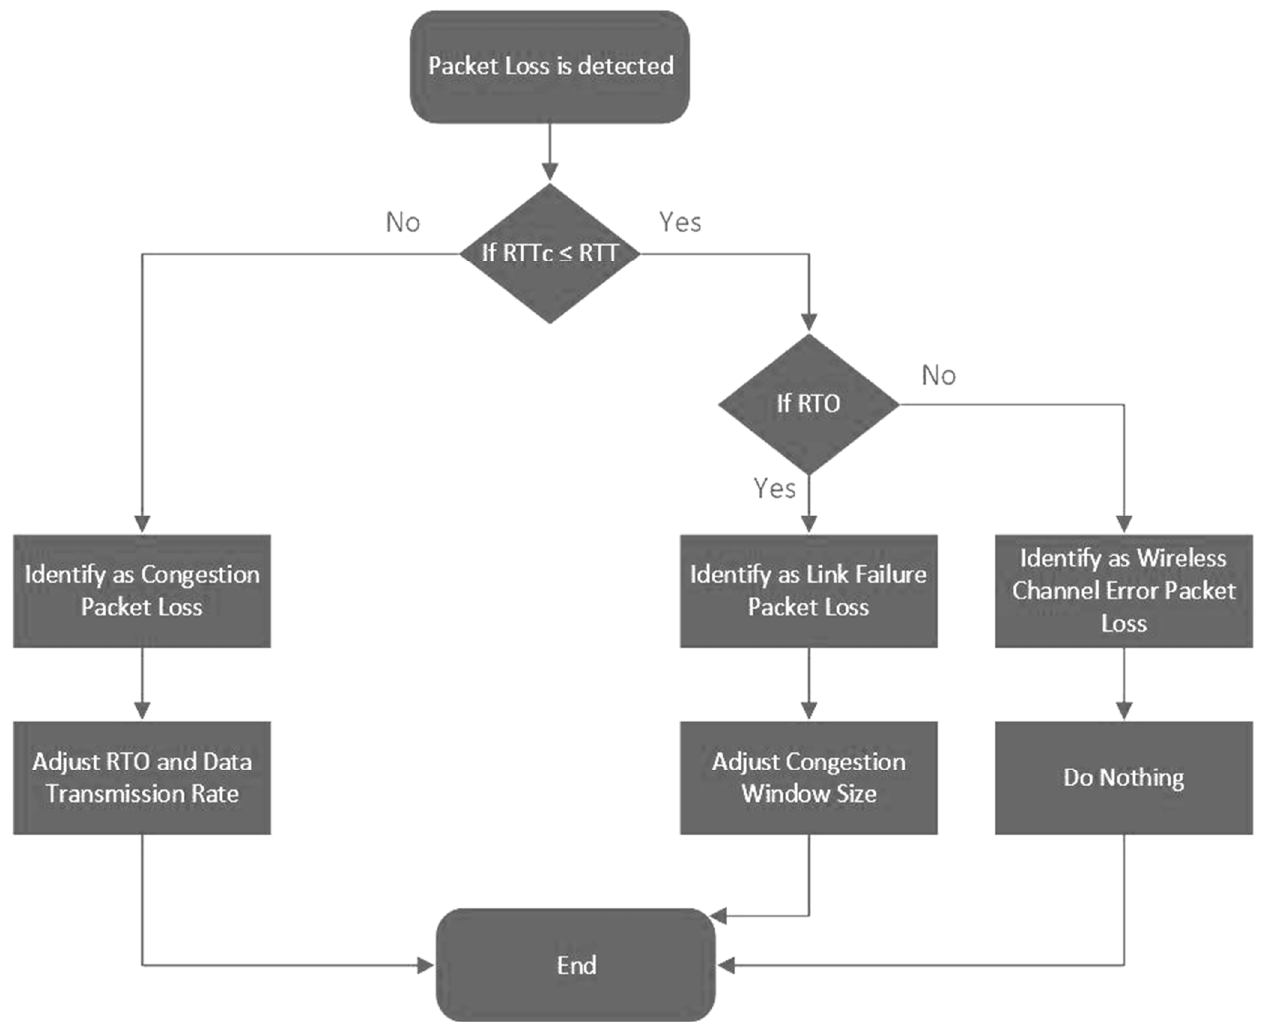
Figure 1. Flowchart of the proposed TCP-LoRaD Algorithm.